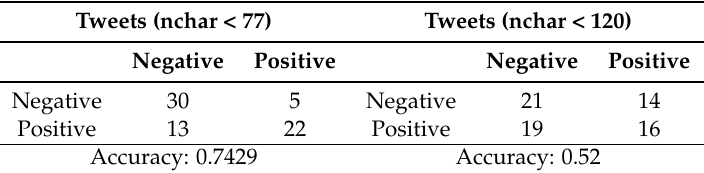
Table 7. Logistic classification by varying Tweet